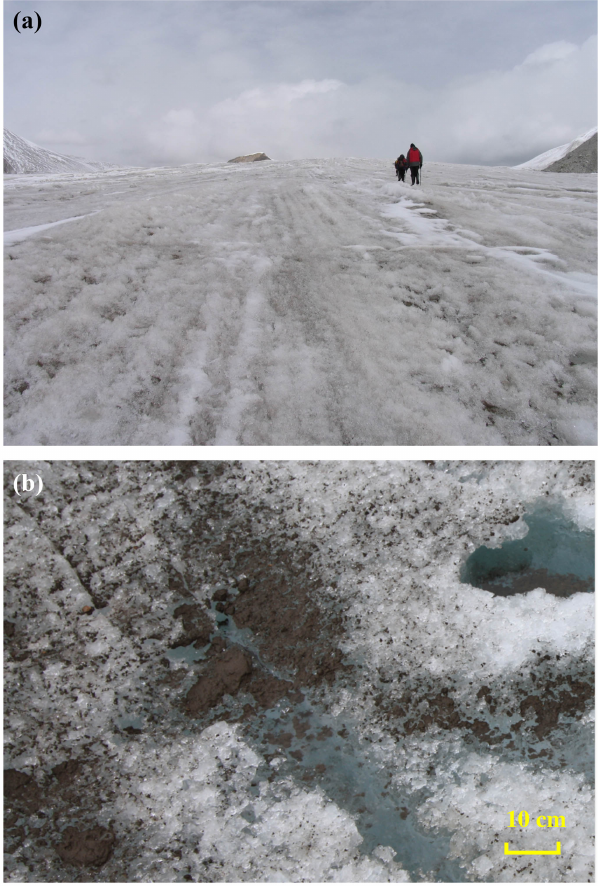
Figure 1. Surface of mountain glacier (a) in the central Tibetan Plateau and dispersed cryoconite (b) on